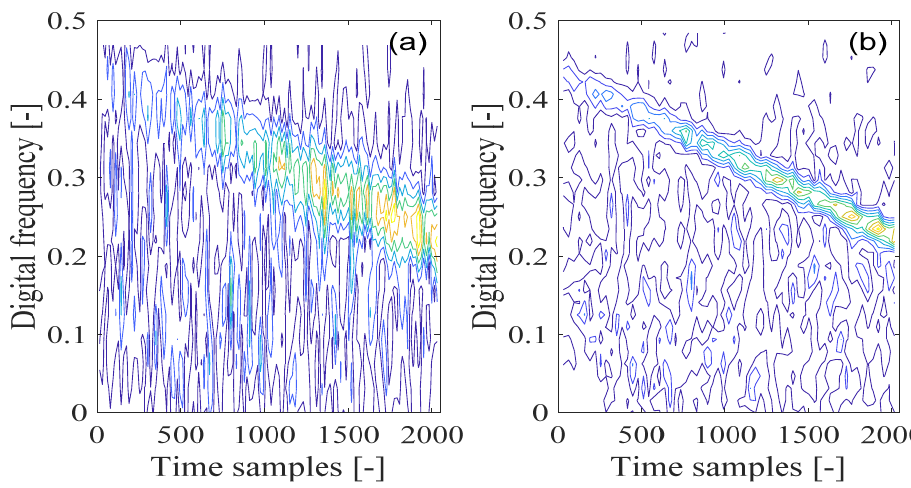
Figure 9. The spectrogram of GPS L1-C/A signal disturbed by the sweep interference; ( a ) window